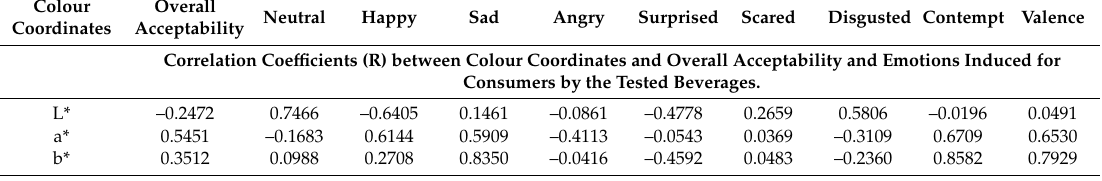
Table 11. Correlation coe ffi cients between colour coordinates and overall acceptability and emotions induced for consumers by the tested beverages. Colour Overall Neutral Happy Sad Angry Surprised Scared Disgusted Contempt Coordinates Acceptability